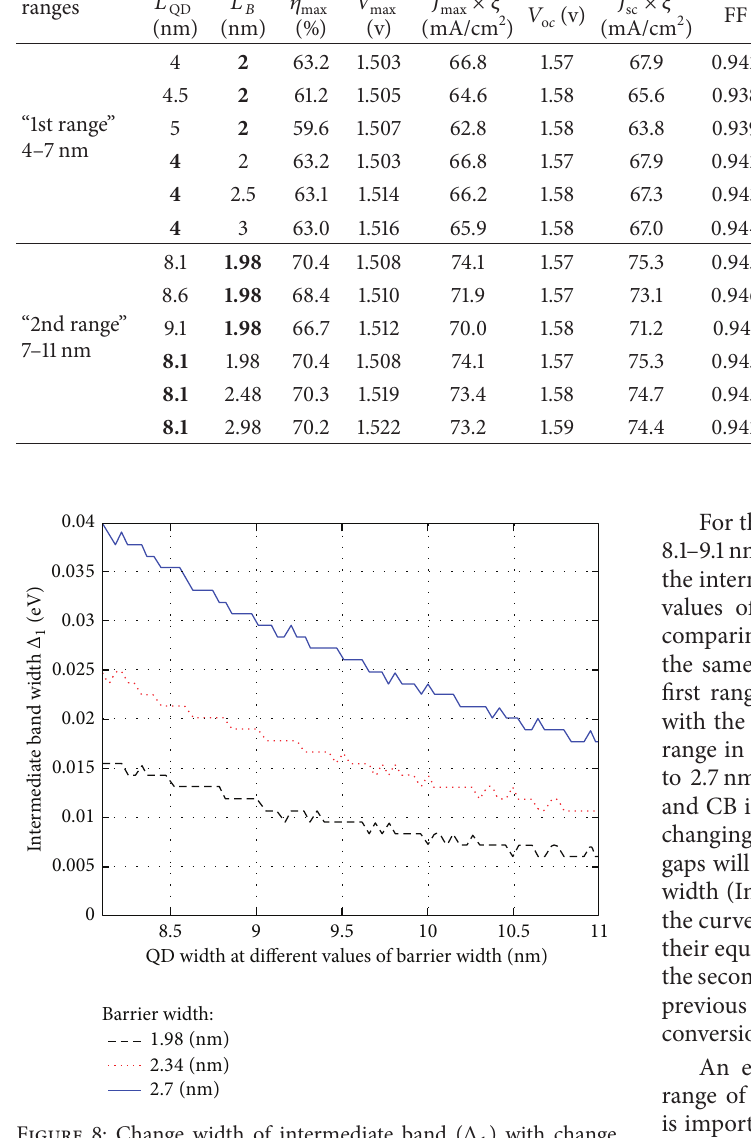
Table 2: Three different values of QD width (InAs at full concentration and unconcentration.